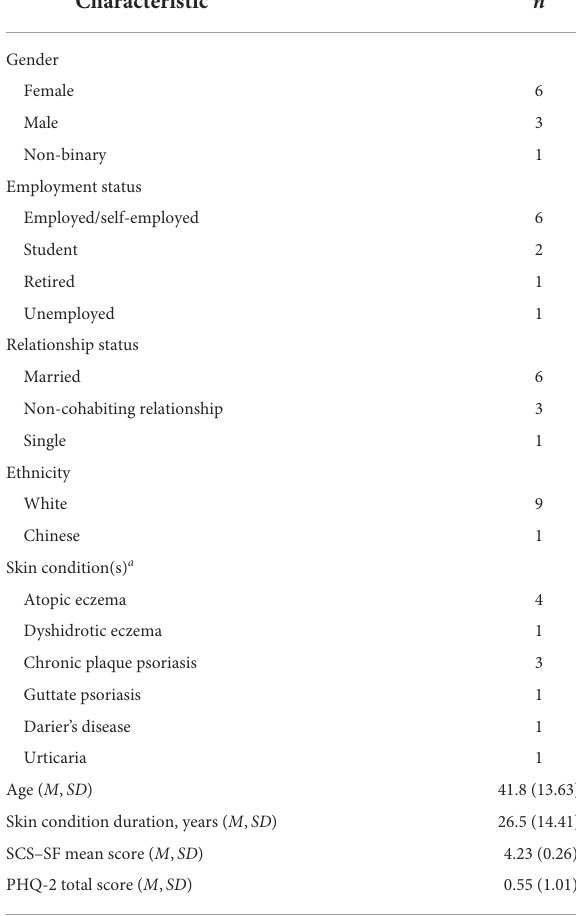
TABLE 1 Demographic and clinical characteristics of participants ( N =